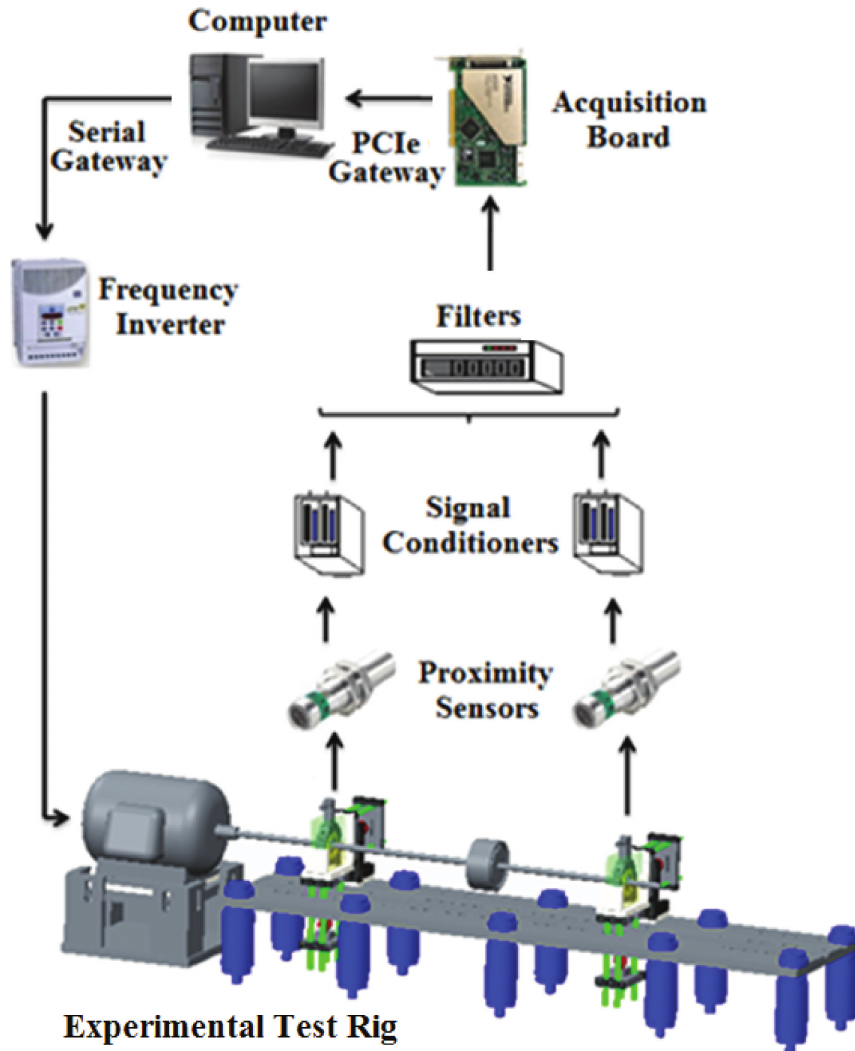
Figure 9 - Scheme of the acquisition and data